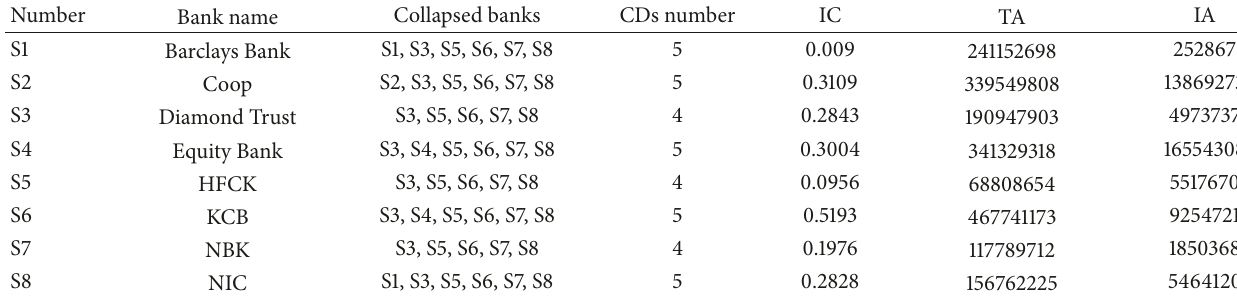
Table 4: Results of stress test in